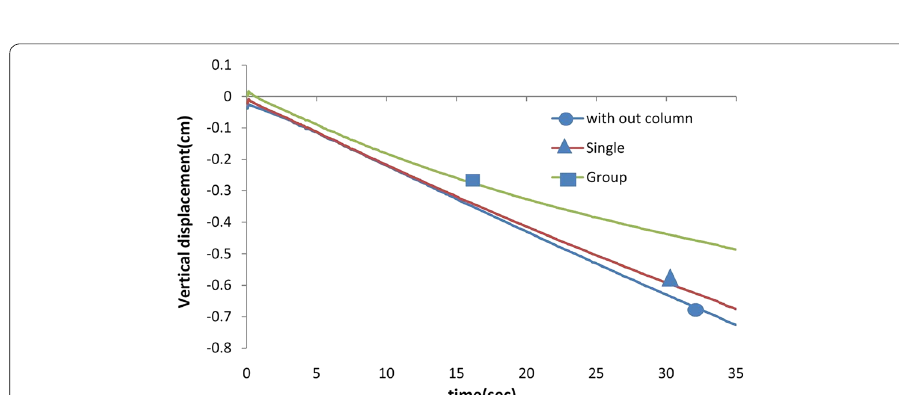
Fig. 20 Changes vertical displacement against time